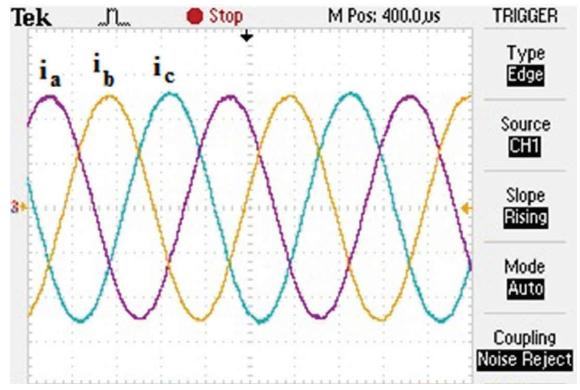
Figure 27: Line current